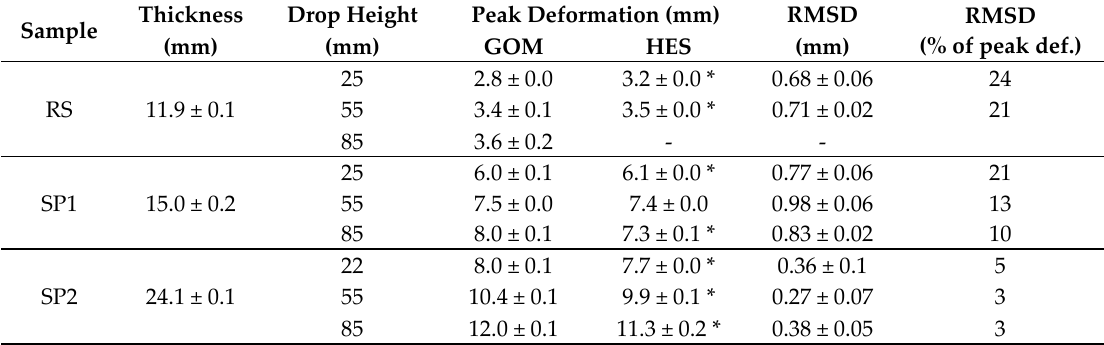
Table 1. Peak sample deformations and strain root mean square difference for GOM and Hall effect sensors during dynamic impact